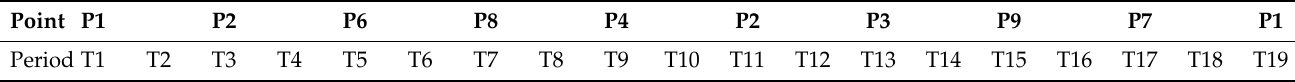
Figure 12. x- and y-values in the saccade task. ( a ) Overall result of all periods. ( b ) Local result of period T7.